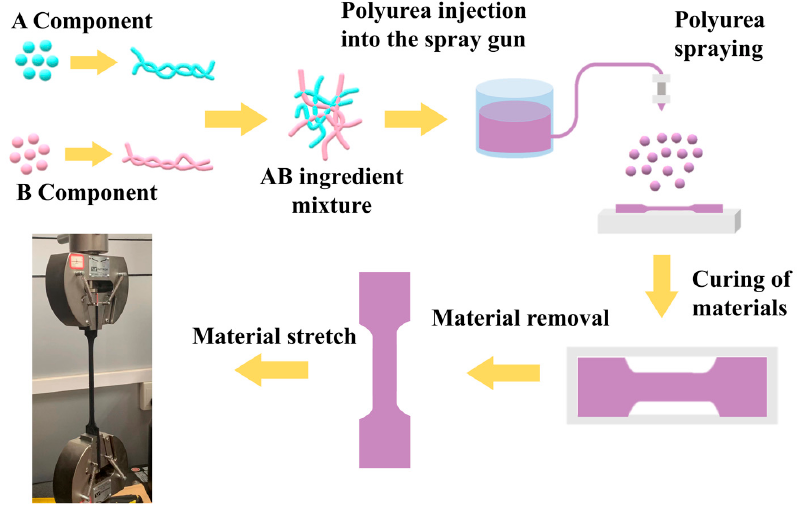
Figure 1. Synthesis process and stretching of the polyurea specimen.